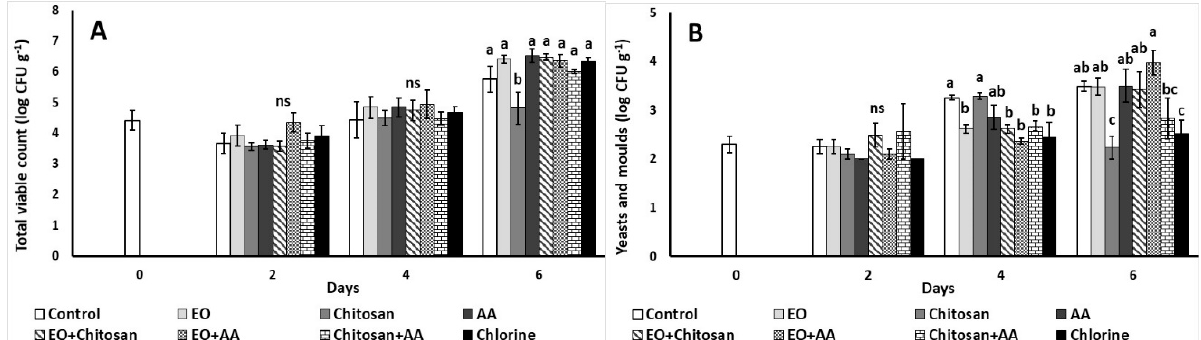
Figure 8. Effect of marjoram essential oil (EO), chitosan and ascorbic acid (AA) on shredded carrots on ( A ) total viable count (TVC; log CFU g − 1 ) and ( B ) yeast and molds (log CFU g − 1 ) after 6 days of storage at 7 °C and 90% RH. On the columns, significant differences ( p < 0.05) among treatments are indicated by different Latin letters; ns indicates no significant differences for different days. Values represent means (±SE) of measurements made on three biological replicates per treatment.